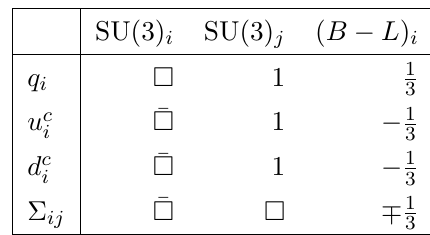
Table 1 . Particle content and charges under the family SU(3) factors and family B for a simple 3-generation model ( i; j = 1 ; 2 ;